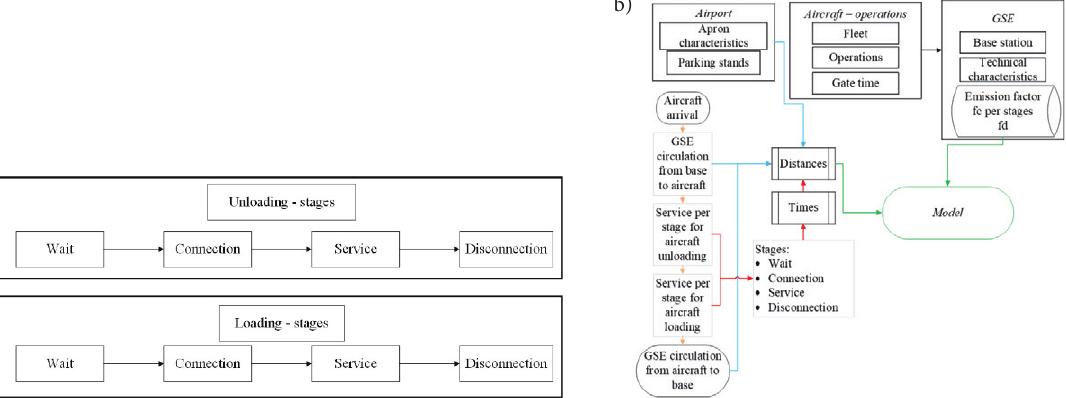
Figure 1. Process an d data to be entered into the model: a – service processes. Discretization of service time at stages for general GSE loading and unloading; b – logical work process to determine air pollution and number of required vehicles